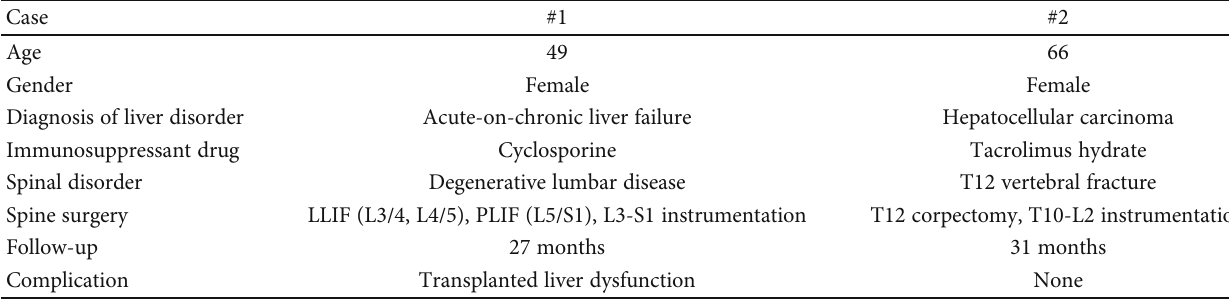
Table 1: Patient ’ s characteristics.